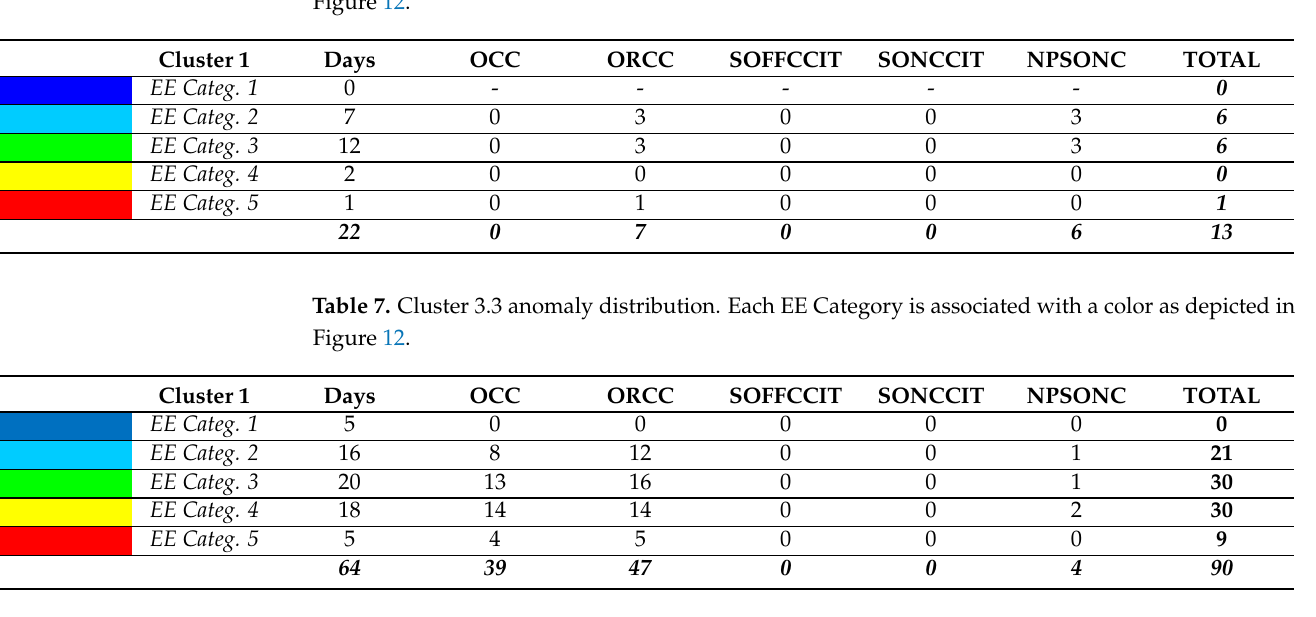
Table 6. Cluster 3.2 anomaly distribution. Each EE Category is associated with a color as depicted in Figure 12.